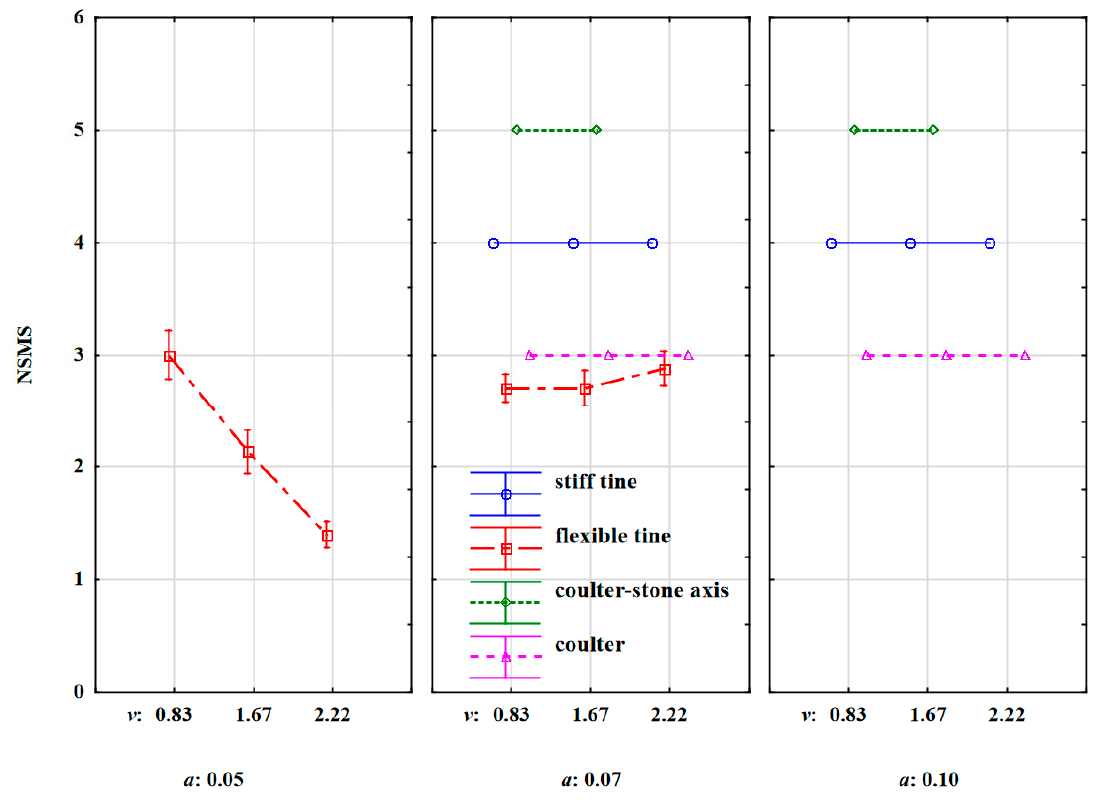
Figure 13. Numerical Stone Movement Scale ( NSMS) determining the behaviour of the location of stones shifted under the influence of forces coming from the stiff tine, flexible tine, coulter-axis and coulter working at varied depths and working speeds.